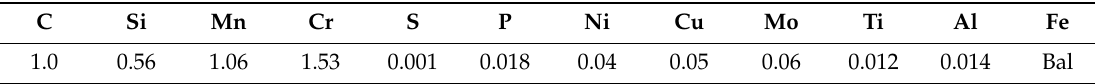
Table 1. Chemical compositions of GCr15SiMn electroslag remelting (ESR) ingot.